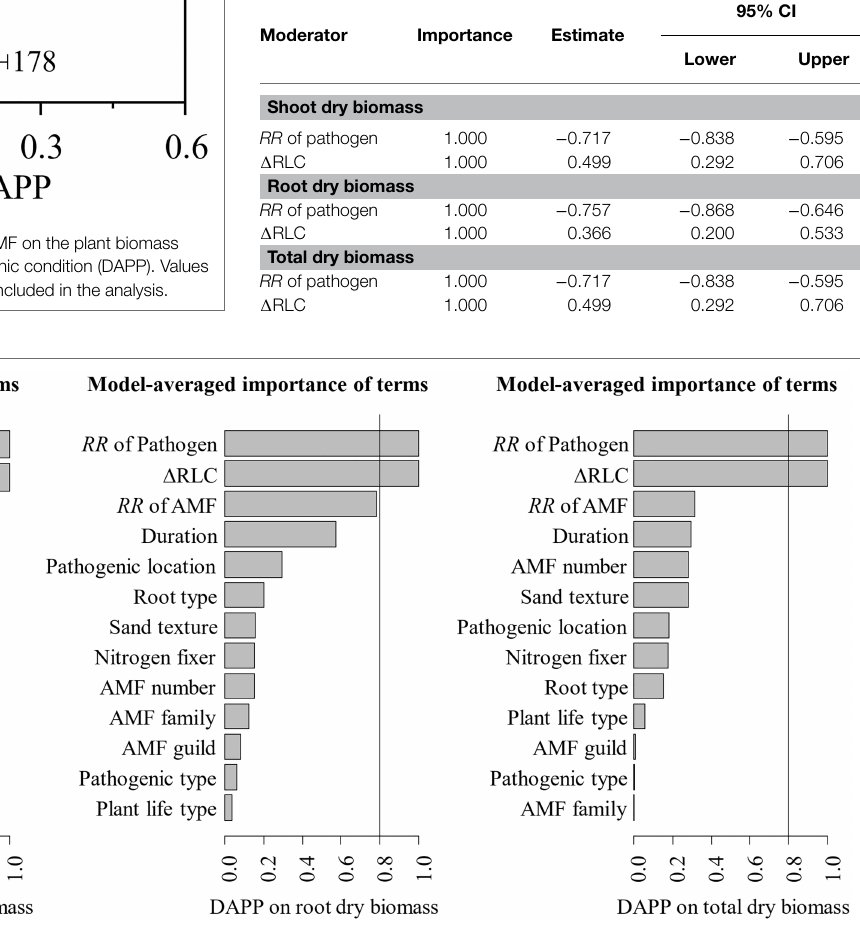
FIGURE 4 | Variable importance of moderators for the effect size difference of AMF on the plant dry biomass under plant pathogenic microbes and no-pathogenic conditions (DAPP). The importance values are the sum of the weights for the models in which the variable appears. The averaged models included the top 128 candidate models. Moderators with an importance of 0.8 or greater are considered for the significance tests.